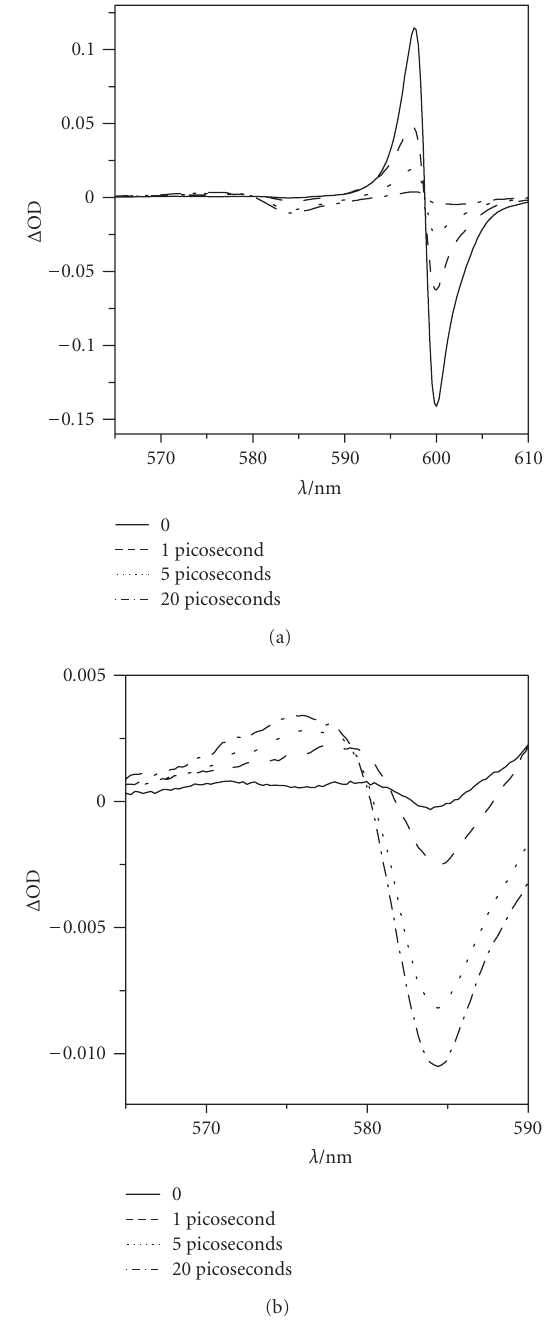
Figure 10: (a) Dynamics of the pump-probe spectrum of pure C8O3 aggregates during the first 20 picoseconds after excitation at 600 nm, (b) dynamics in the vicinity of 580 nm (band